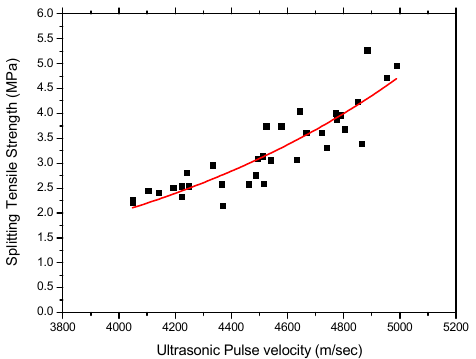
Figure 8. Relationship between UPV and Splitting tensile strength.